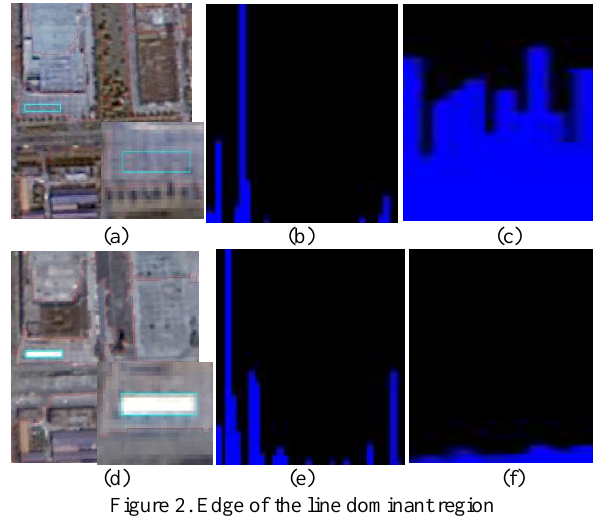
Figure 2. Edge of the line dominant